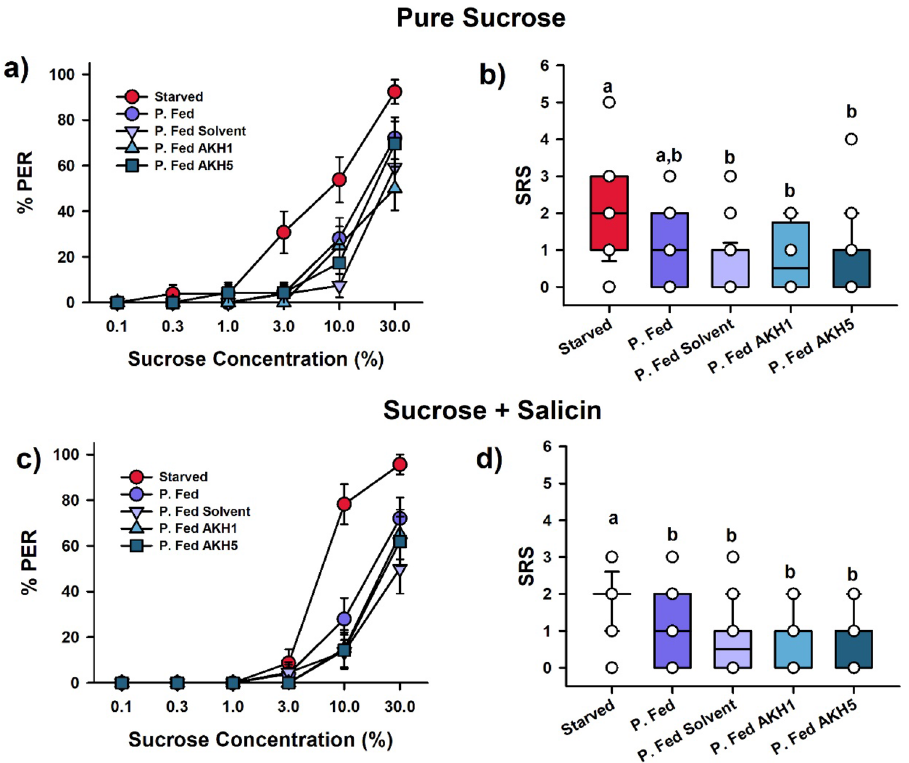
Figure 5. Sucrose responsiveness of partially fed (‘P. Fed’) foraging bees under AKH treatment. Population responses ( a,c ) and individual sucrose responsiveness scores ( b,d ). Bees were either starved (‘Starved’) or partially fed with a honeydew diet. Partially fed bees were left untreated (‘P. Fed’), topically exposed with solvent (‘P. Fed solvent’) or with AKH (either 1 or 5 µg; ‘P. Fed AKH1’ and ‘P. Fed AKH5’, respectively). ( a ) Cumulative proportions of bees showing PER (proboscis extension response) when presented with six pure sucrose solutions of increasing concentration (0.1%, 0.3%, 1%, 3%, 10% and 30% w/w). The percentage of starved bees (n = 26) responding to the three highest sucrose concentrations was higher, yet not significant (P = 0.05), than those of all P. Fed groups (P. Fed, n = 21; P. Fed Solvent, n = 27; P. Fed AKH1, n = 28; P. Fed AKH5, n = 23). ( b ) Individual sucrose response scores (SRS) of bees responding to six pure sucrose solutions of increasing concentration (0.1%, 0.3%, 1%, 3%, 10% and 30% w/w). The figure shows the median (horizontal line) and the 10th, 25th, 75th and 90th percentiles as vertical boxes with error bars and the corresponding overlaid scatter plots. SRS values ranged between six (bees responding to all six concentrations) and 0 (bees not responding to any concentration). Starved bees had significantly higher scores than P. Fed solvent and P. Fed AKH bees. P. Fed bees had intermediate SRS values. Different letters above box plots indicate significant differences (P < 0.05). ( c ) Cumulative proportions of bees showing PER (proboscis extension response) when presented with six solutions of sucrose of increasing concentration (0.1%, 0.3%, 1%, 3%, 10% and 30% w/w) to which 100 mM salicin was added. Starved bees (n = 23) responded more than P. Fed (n = 25) and P. Fed AKH1 bees (n = 20) (P < 0.05 in both cases) for the two highest sucrose concentrations spiked with salicin (10 and 30%). The other comparisons involving starved bees, P. Fed Solvent bees (n = 22) and P. Fed AKH5 bees (n = 21) were not significant. ( d ) Individual sucrose response scores (SRS) of bees responding to six pure sucrose solutions of increasing concentration (0.1%, 0.3%, 1%, 3%, 10% and 30% w/w) spiked with 100 mM salicin. The figure shows the median (horizontal line) and the 10th, 25th, 75th and 90th percentiles as vertical boxes with error bars and the corresponding overlaid scatter plots. Starved bees had significantly higher scores than all fed bees. Different letters above box plots indicate significant differences (P < 0.05). Overall, no effect of AKH on sucrose responsiveness could be